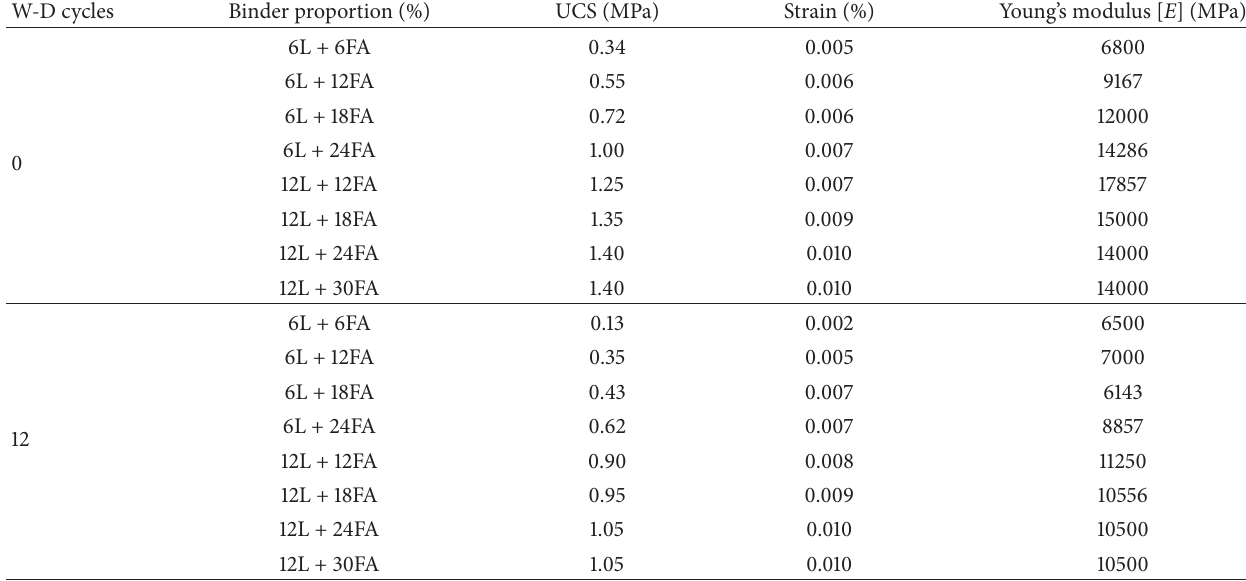
Table 10: Wet-dry cycles for lime and fly-ash